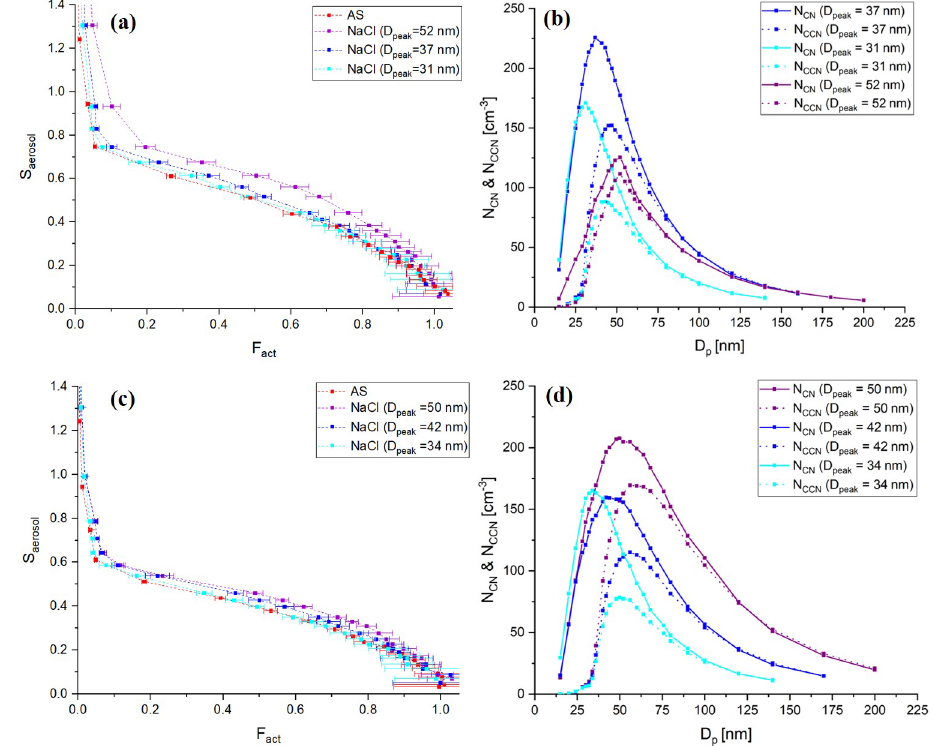
Figure 5. Calibration curves of ammonium sulfate and sodium chloride for (a) d T = 10K and (c) d T = 8K as well as the number size distribution of N CN and N CCN for sodium chloride particles for (b) d T = 10K and (d) d T = 8K. Table 1. Coefficients and goodness of fit for calibration curves for three different d T conditions (d T = 10, 8, and 6K). Three different statistical values, including error sum of squares (SSE), coefficient of determination ( R 2 ), and root mean square error (RMSE), are used to judge the goodness of